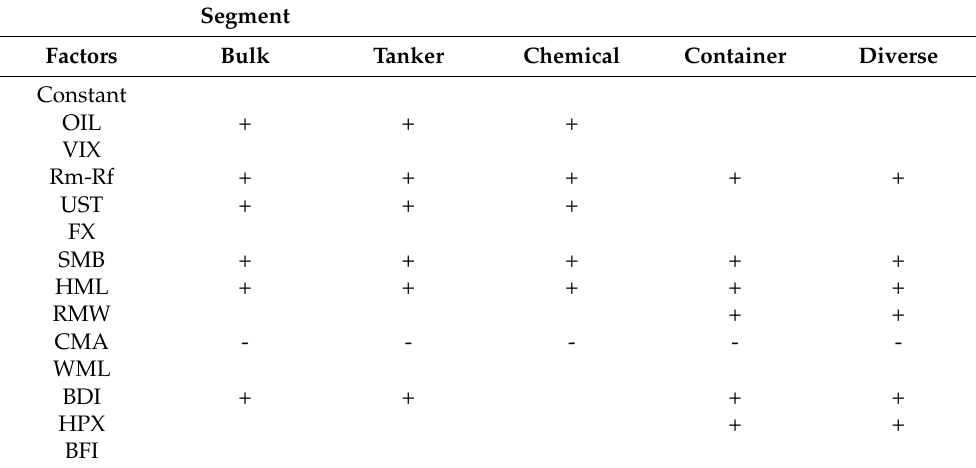
Table 9. Summary of significant effects from factor by shipping segment (OLS regression).